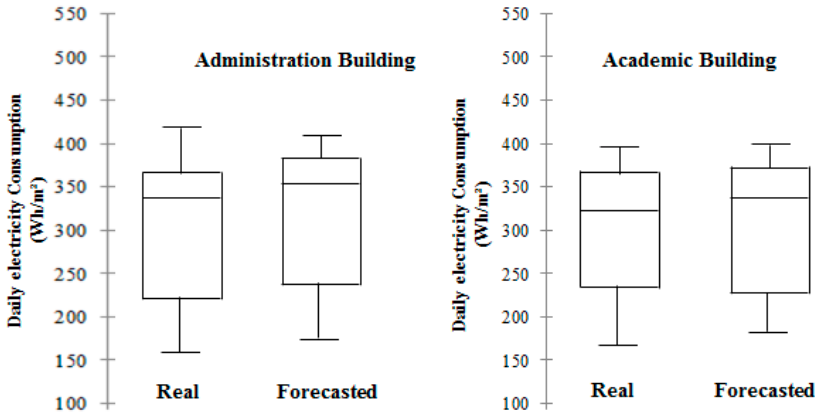
Figure 9. Box plot comparison of real and predicted daily electricity consumption of two types of buildings.